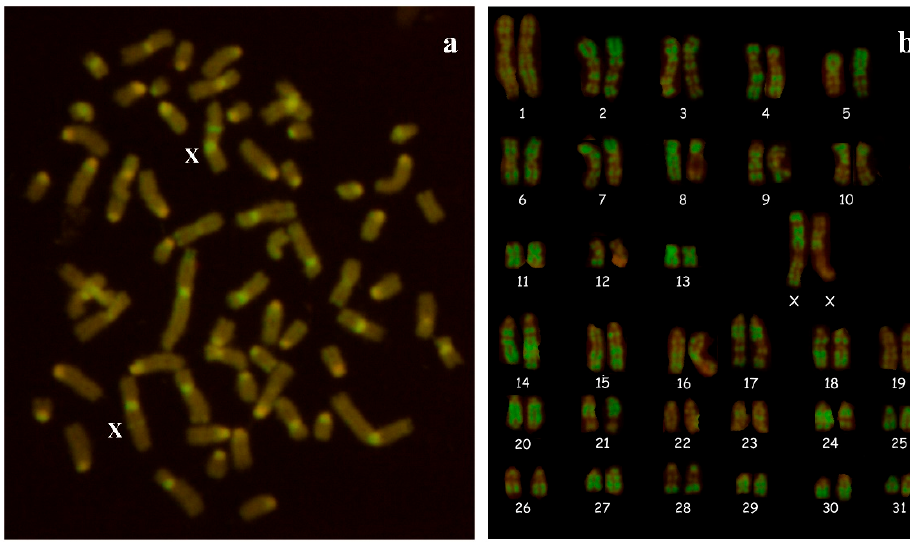
Figure 4. Cytogenetic analysis. ( a ) C-banded metaphase plate with 2n = 64,XX and ( b ) R-banded karyotype with 2n = 64,XX of the Arabian horse with ambiguous genitalia.